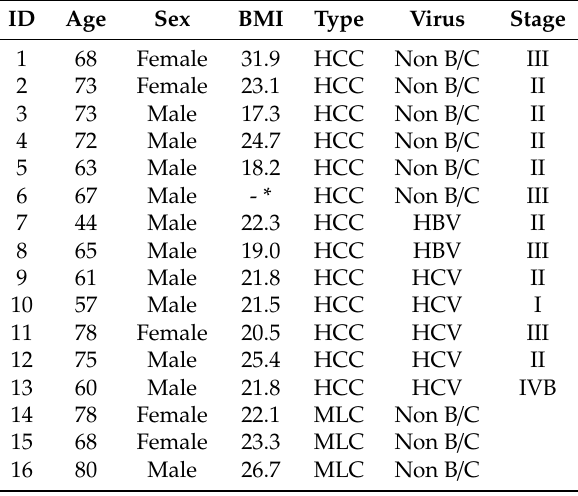
Table 1. Clinical characteristics of patients in this study.